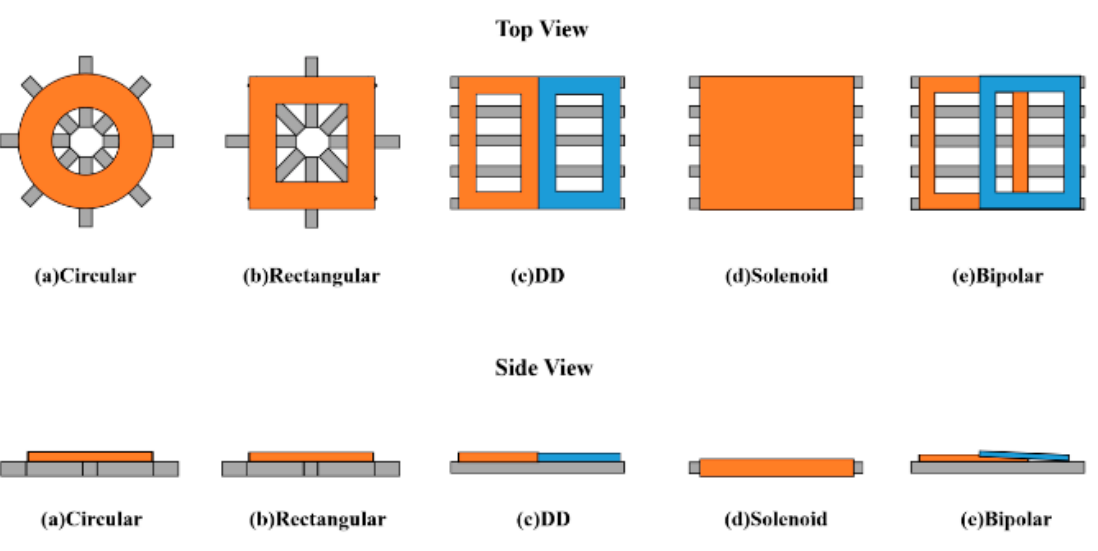
Figure 3. Typical transformer structures of the WPT system.